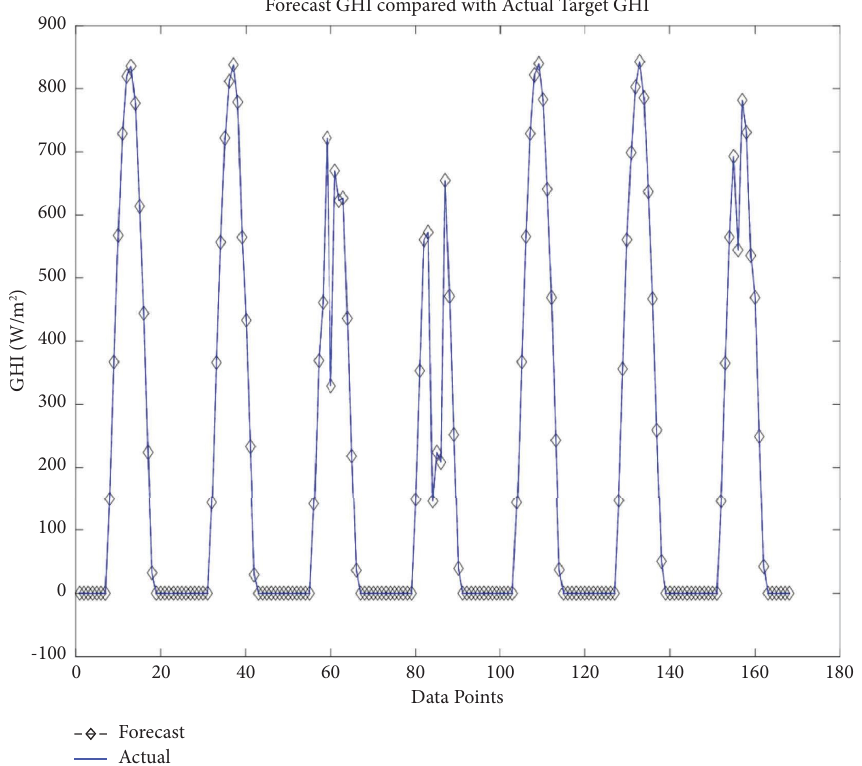
Figure 4: Forecast GHI compared with the actual target